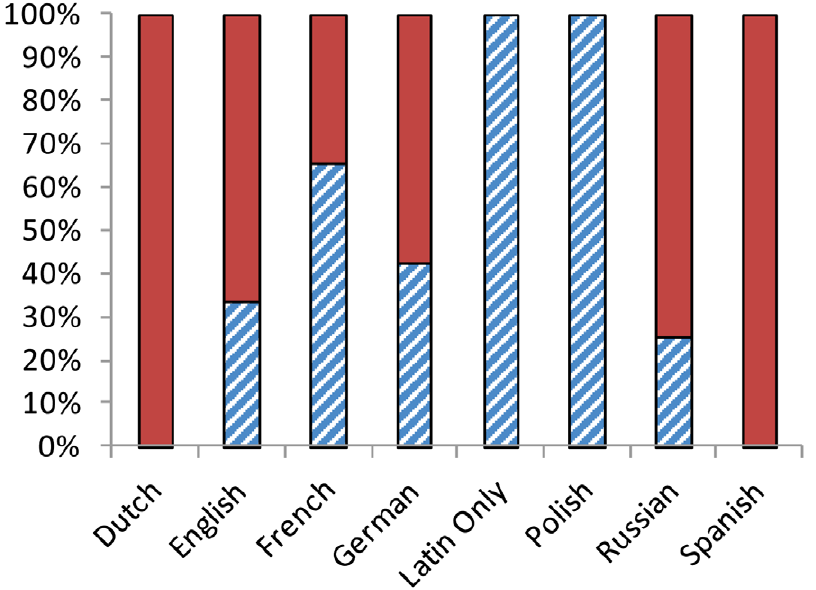
Figure 1. Proportion of oncers described in each language. The proportion of oncers in Gymnodinium originally described in each language is given in blue stripes.